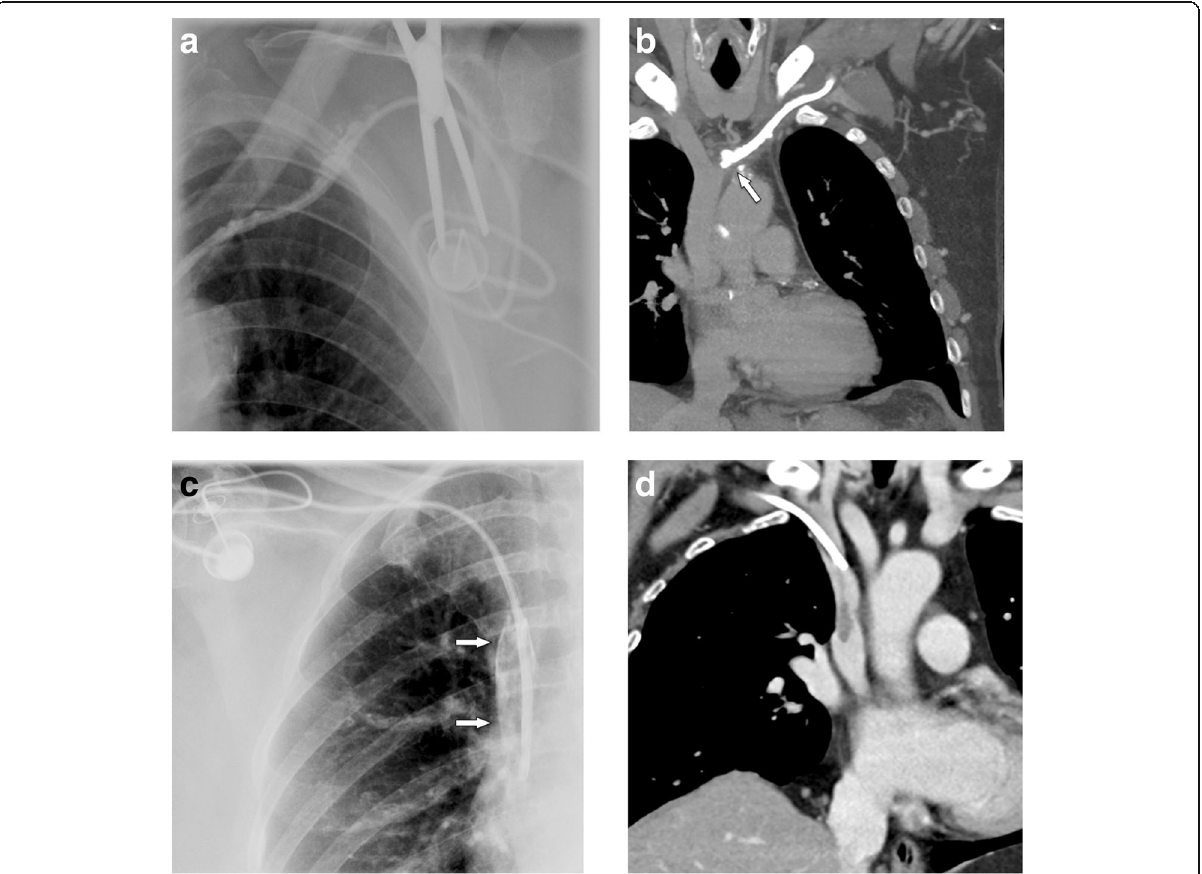
Fig. 11 Thrombosis. a Flow confirmation study shows contrast backflow around the catheter. It is not clear, whether the catheter is in an intravascular position. b CT was subsequently performed, which shows the tip of the catheter too high in the brachiocephalic vein with venous thrombosis and development of multiple collaterals. c In another patient with increased resistance during infusions, flow confirmation study shows a fibrin sheath around the catheter (arrows). Infusion of thrombolytics (rTPA) restored good flow of the system. d In another patient, incidental finding of a thrombus at the catheter tip detected during contrast-enhanced MDCT